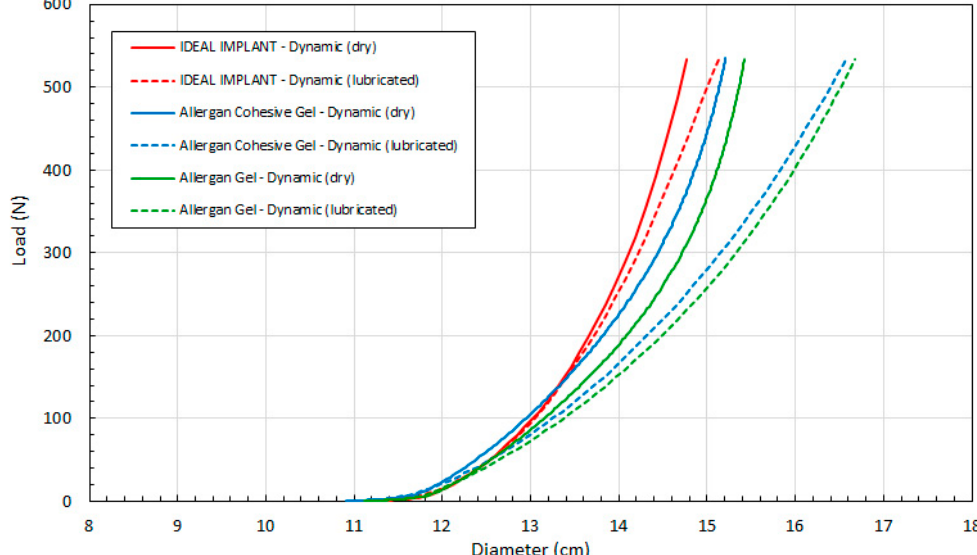
Figure 9. Load (F) as a Function of Implant Diameter (D) for Dynamic Testing, Dry and Lubricated Platens.